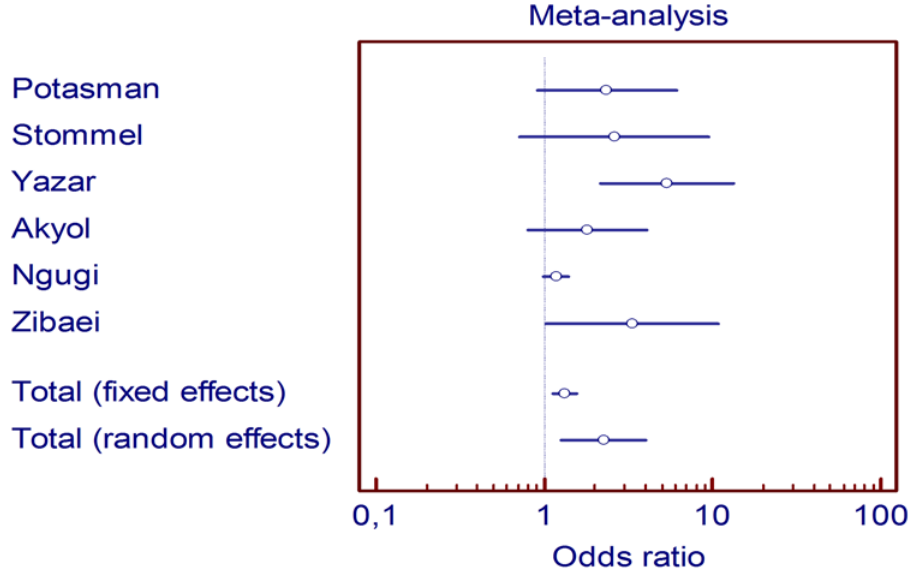
Fig 2. Scatter plot of odds ratios for epidemiological correlation between toxoplasmosis and